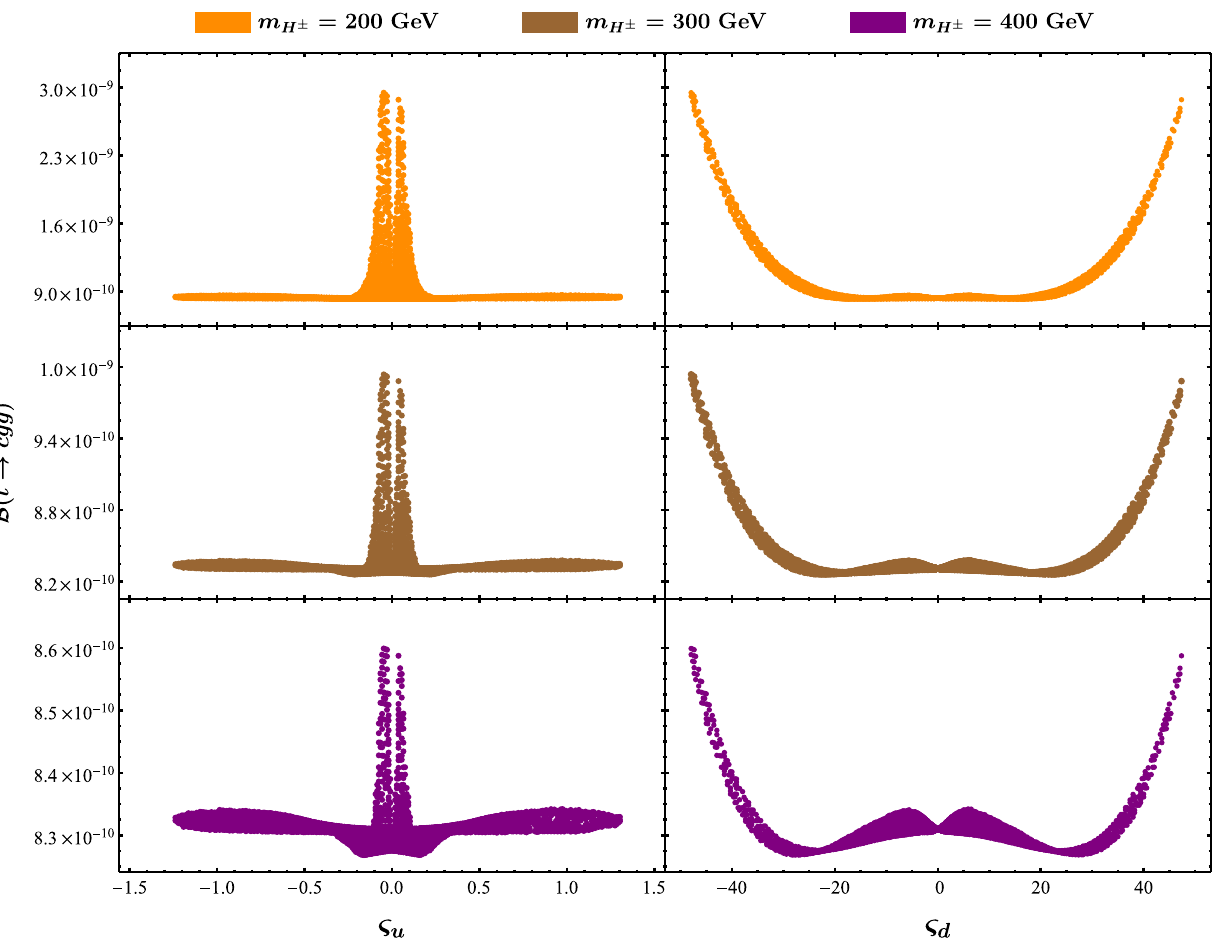
Fig. 4 The branching ratio B ( t → cgg ) as a function of the align- ment parameters ς u (left) and ς d (right), for three benchmark values of the charged-Higgs mass, m H ± = 200, 300, and 400GeV, represented